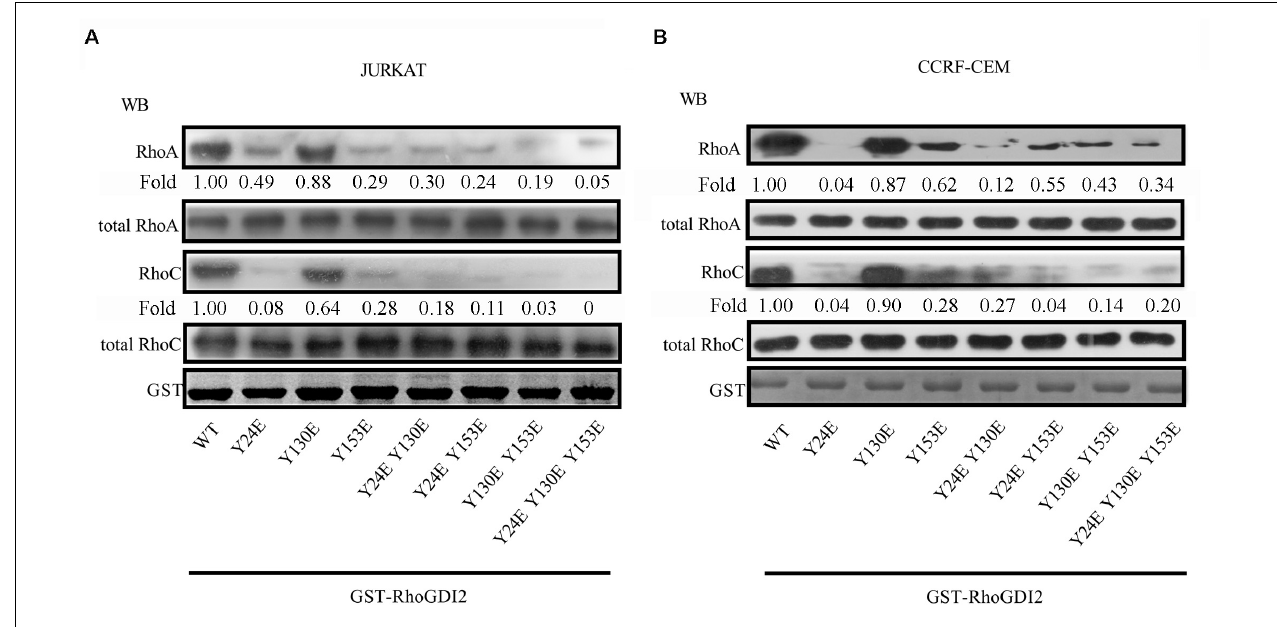
FIGURE 4 | Phosphorylation of Tyr24 or Tyr153 dissociates RhoA or RhoC from RhoGDI2 and accelerates the activation of RhoA and RhoC. Cell lysates of JURKAT (A) or CCRF-CEM (B) cells were incubated with WT or mutants of GST-GDI2 in the GST pull-down assay. Then, RhoA or RhoC antibody was used in the Western blot assay to detect the level of RhoA or RhoC bound in the complex. Western blot bands were analyzed using Image Pro Plus 6.0, and fold changes of bound RhoA or RhoC were normalized according to total RhoA or RhoC. Total RhoA or RhoC was used as loading controls. GST-RhoGDI2-WT or mutants equal to that used in the GST pull-down assay were loaded and stained with coomassie blue and used as another